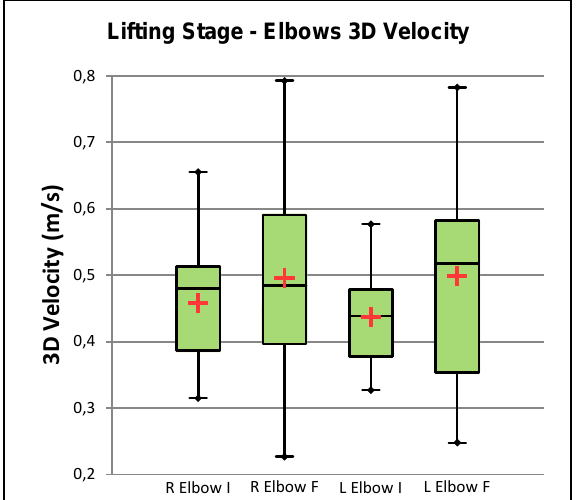
Figure 11. Elbows Lifting 3D Velocity